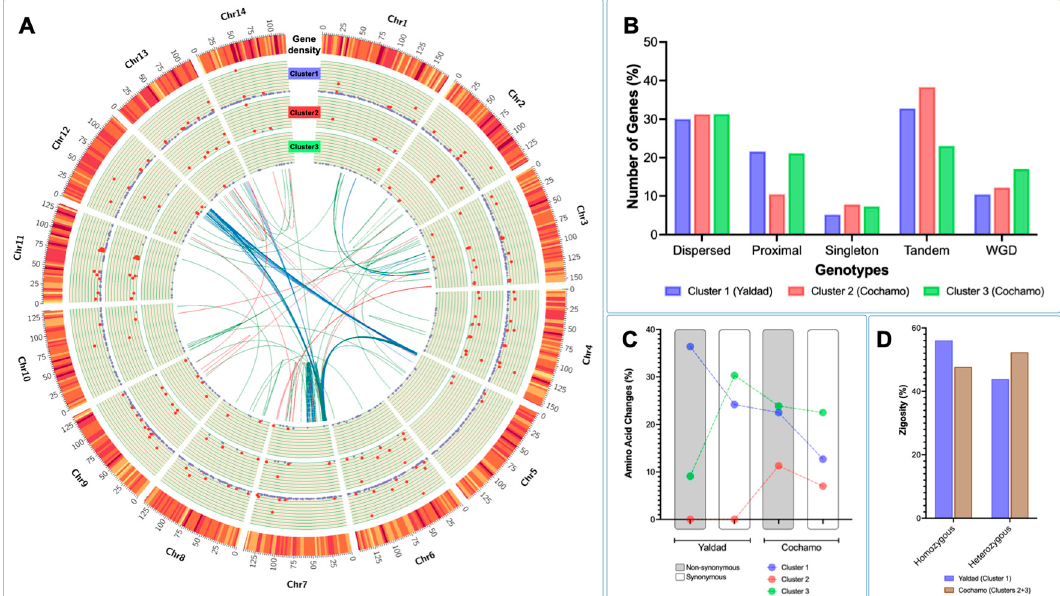
Figure 7. Genetic polymorphisms annotated in di ff erentially expressed genes (DEGs) analyzed between the Yaldad and Cochamó mussel populations. The evaluation of DEGs was performed by cluster transcriptome analysis. ( A ) Circos plot showing DEGs identi fi ed in the three analyzed clusters. From outer to the inner circle: gene density, DEG cluster 1, DEG cluster 2, DEG cluster 3, and syntenic relationships between DEGs (each color line represents the cluster analyzed). Red dots represent DEGs with fold-change values > |100|, and purple dots represent fold-change values < |10|. ( B ) Genotypes of DEGs identi fi ed in M. chilensis populations according to the transcription cluster analysis. Singleton means that the gene is single-copy, which should not be the type of members of gene families. Dispersed means that the gene might arise from transposition. Tandem means that genes were repeatedly duplicated. Proximal means that the gene might arise from small-scale transposition or from tandem duplication and insertion of some other genes. Whole-genome duplication (WGD) means the gene might arise from a chromosome duplication region. The analysis was carried out using MCScanX . ( C ) Amino acid change proportions (%) between the Yaldad and Cochamó populations. The non-synonymous and synonymous were annotated for the DEGs selected for each mussel population according to the cluster analysis. ( D ) Zygosity proportion (%) estimated for each mussel population. Cluster 1 (Yaldad) is represented by blue bars, and clusters 2 and 3 (Cochamó) are displayed in brown bars.